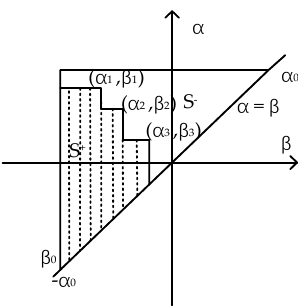
Figure 2. The geometric interpretation of the Preisach model.